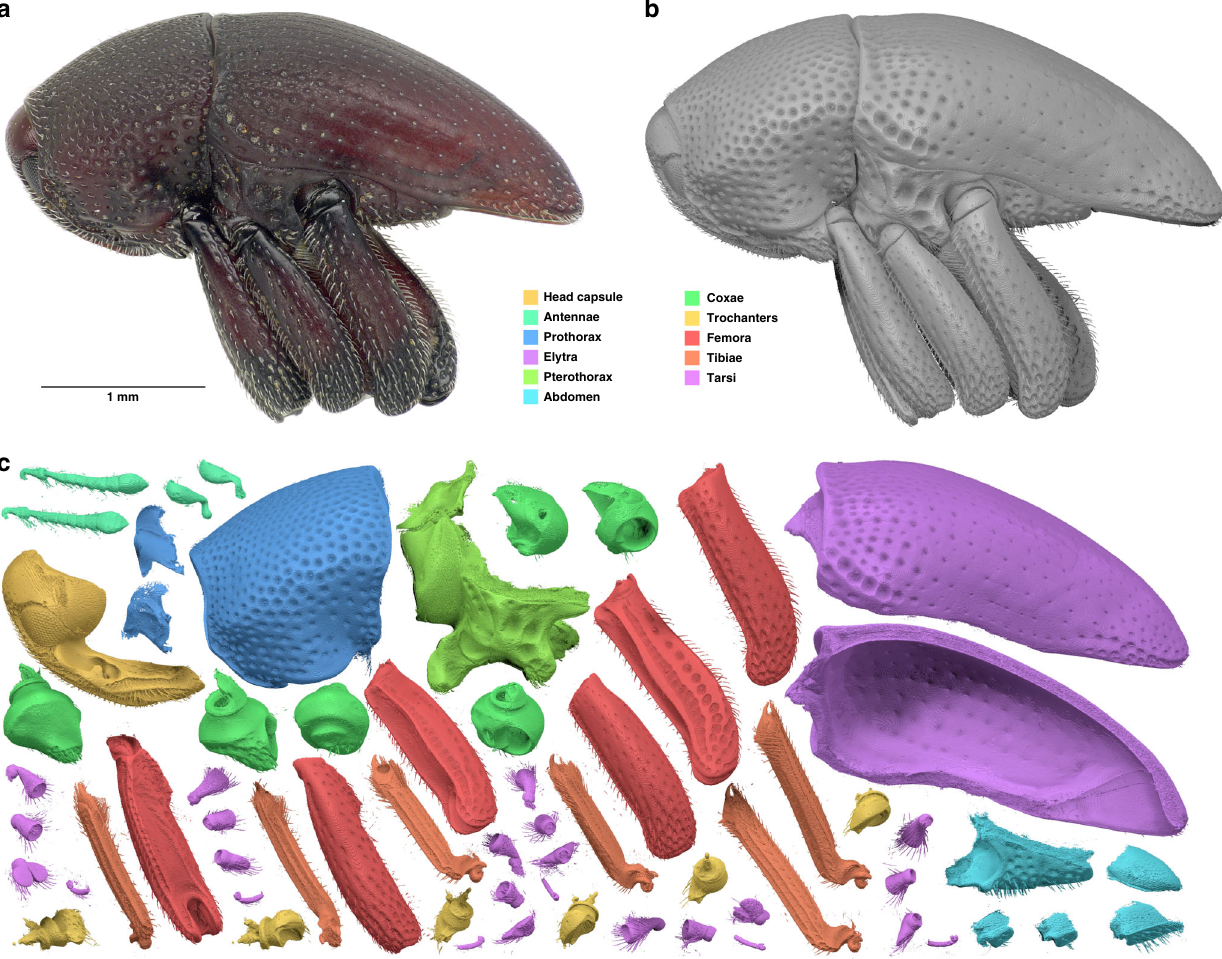
Fig. 2 Biomedisa segmentation using a Trigonopterus weevil as an example. a Photograph of the original specimen. b Result of Biomedisa segmentation based on 37 pre-segmented slices of the tomographic volume adapted to the weevil ’ s morphology. c The 64 isolated body parts of ( b ). The surface meshes shown in this fi gure are based on the original Biomedisa result. If necessary, outliers or minor fl aws in the reconstruction (e.g. tiny holes) can be corrected with low